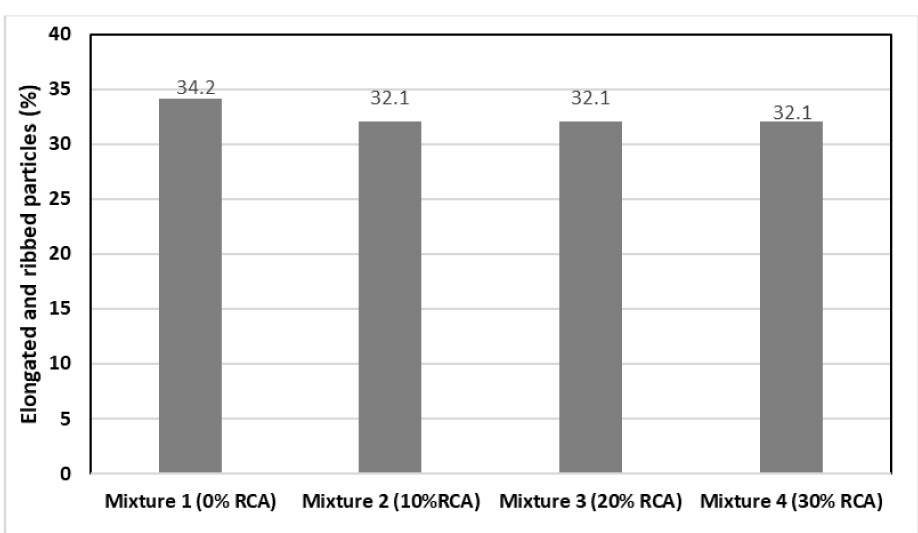
Figure 6. Percentage of Flat and Elongated Particles of the fine